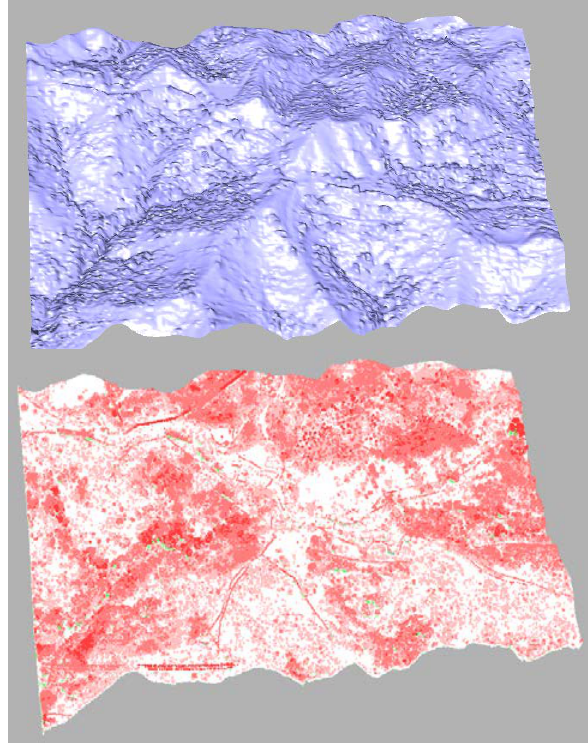
Figure 2: LR B-spline approximation of Liguria dataset and the point classification coloured according to the distance from the surface approximation. White points lie close to the surface, whereas green points lie below the surface tolerance level and red points above.